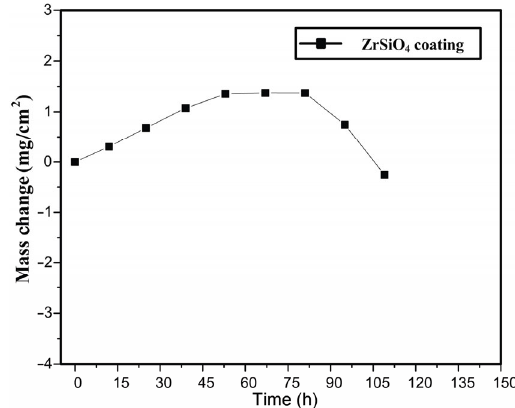
Fig. 5 Weight loss of ZrSiO 4 coating in 90%H 2 O/10%O 2 at 1300 ℃ .